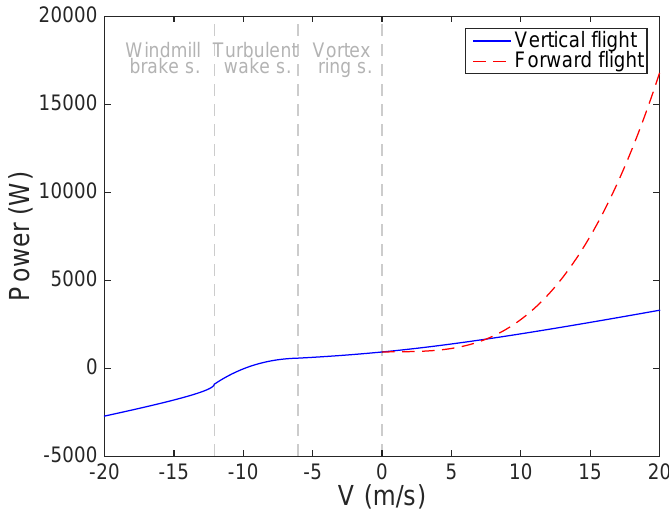
Figure 9. Power consumption models as a function of